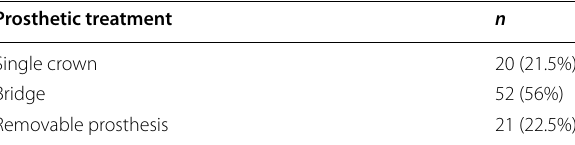
Table 4 Type of prosthesis on included implants [ n